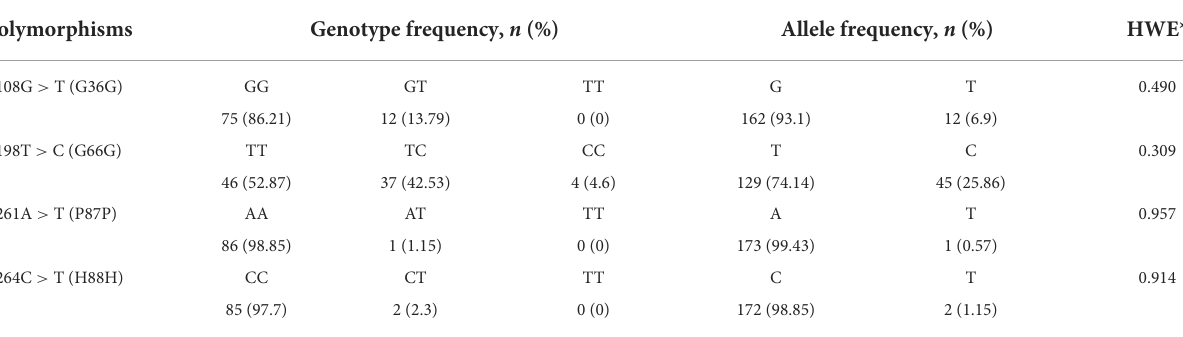
TABLE 1 Genotype and allele frequencies of PRNP polymorphisms in raccoon